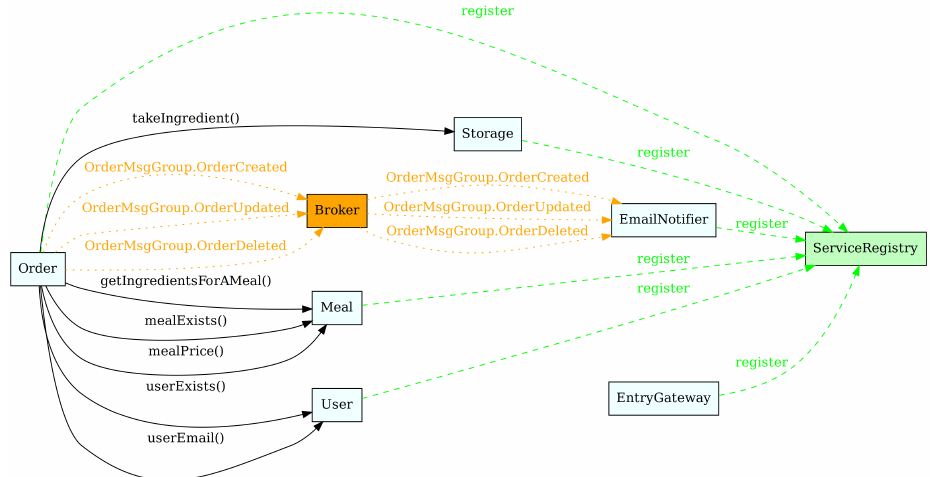
Figure 3. The architecture of the Eat and Drink application. Solid, black connections represent dependencies. The label on dependency connection shows which method is required by dependent. Green, dashed connections represent service registrations. Orange, dashed connections represent a message publishing, and labels on these connections represent messages that are being published.